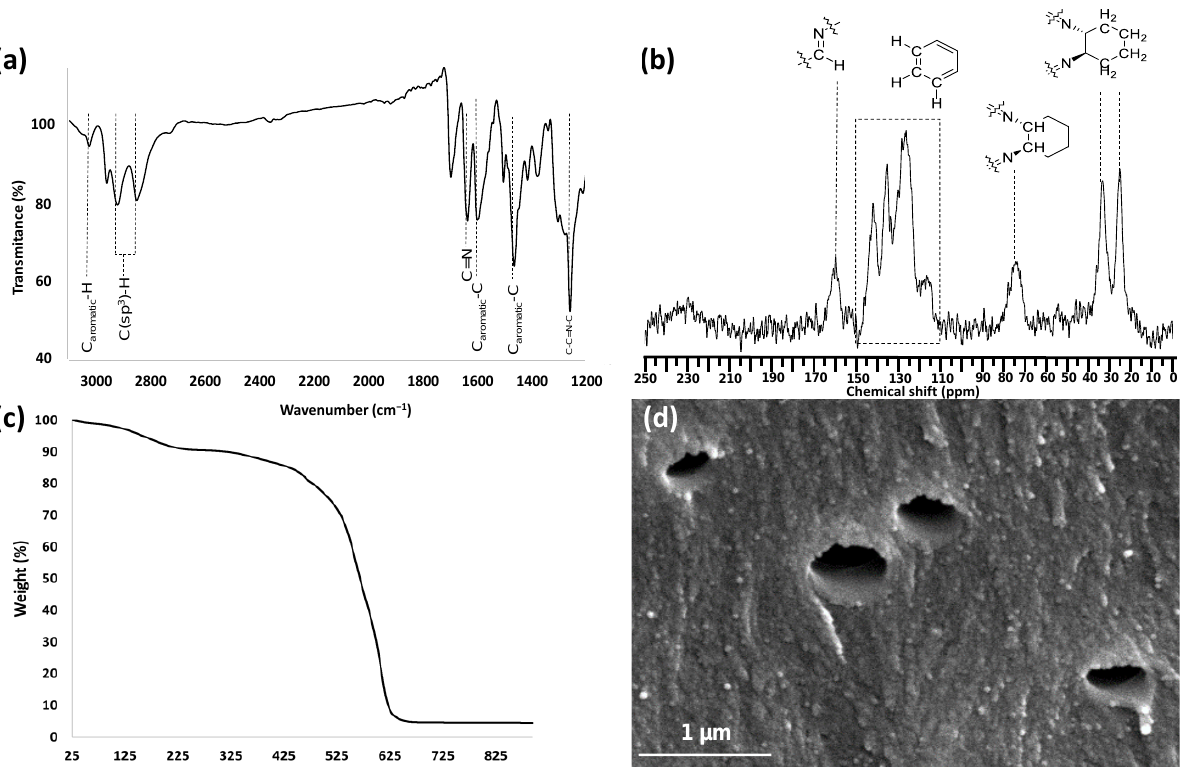
Figure 2. Characterization of PTH-polymer: ( a ) IR spectra; ( b ) solid-state 13 C-NMR spectra (CP-MAS); ( c ) thermogravimetric analysis and ( d ) SEM image.